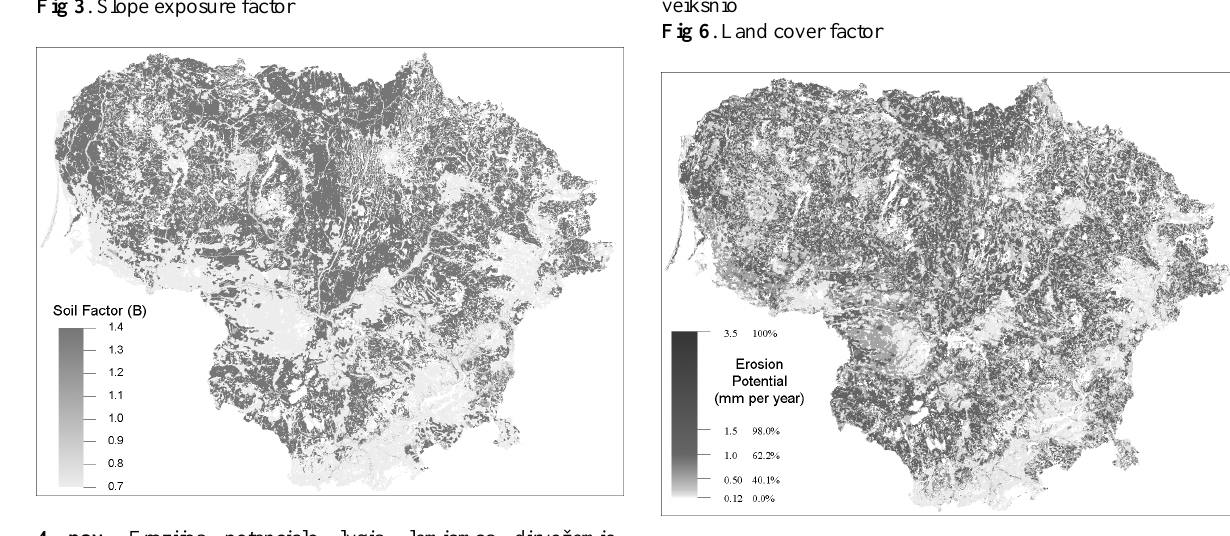
Fig 3 . Slope exposure factor